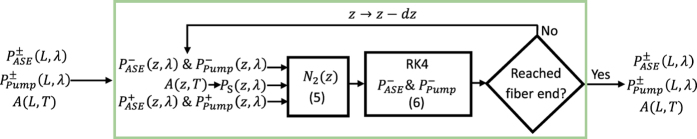
Illustration of the backward propagation, from z = L to z = 0, scheme used in each iteration.The numbers in parentheses denote the equations being used.